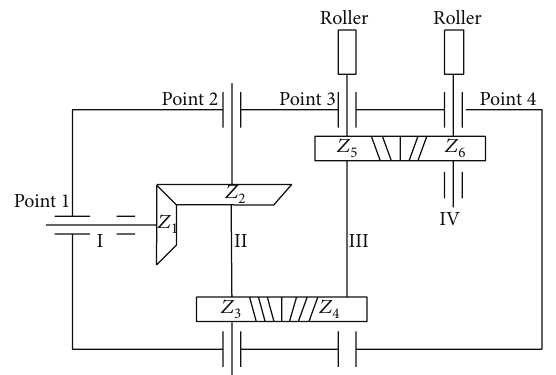
Figure 8: The transmission system and the layout of the measuring point.